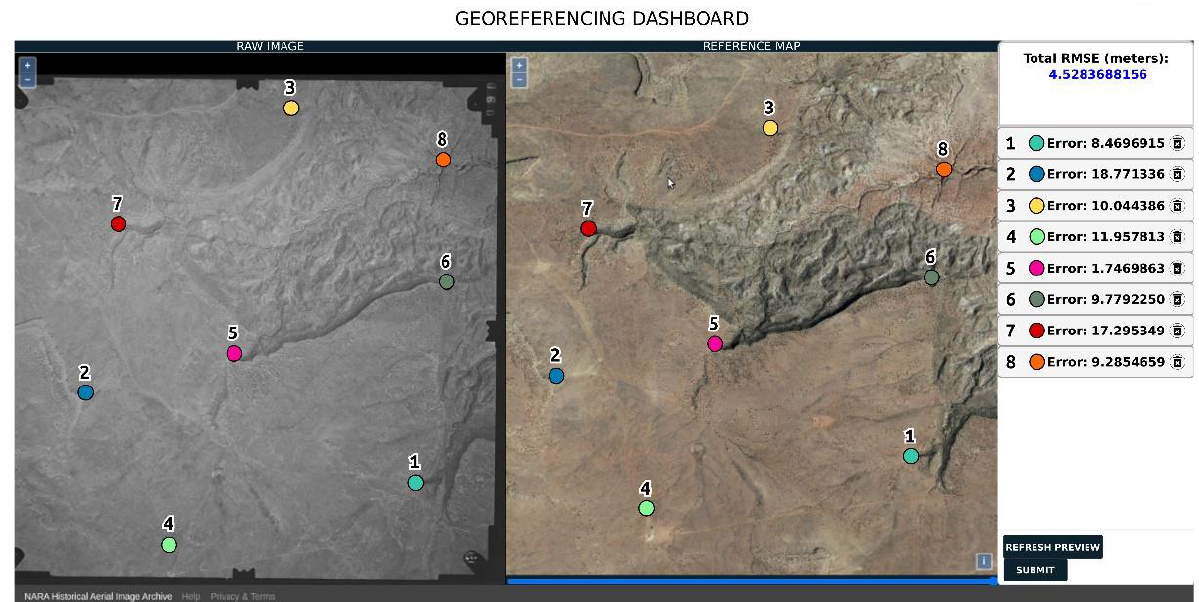
Figure 3. The user interface of the online georeferencing tool. Colored dots on the left image are the GCPs on the historical aerial photos to be georeferenced, while the matching colored dots on the right image are the matching GCPs on the reference image. Accuracy is reported as RSME in meters.